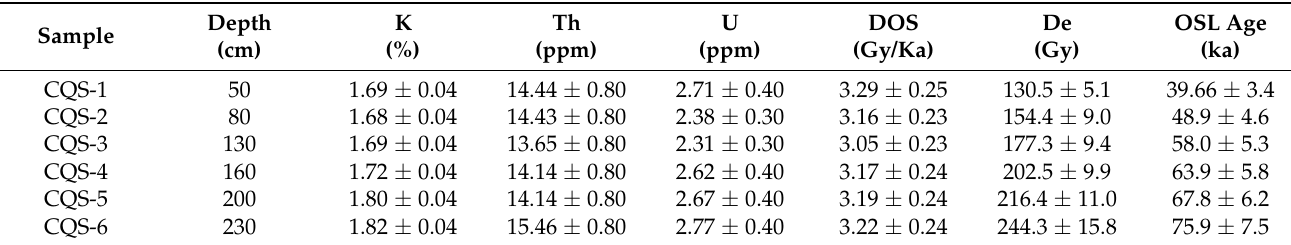
Table 1. Results for OSL ages.